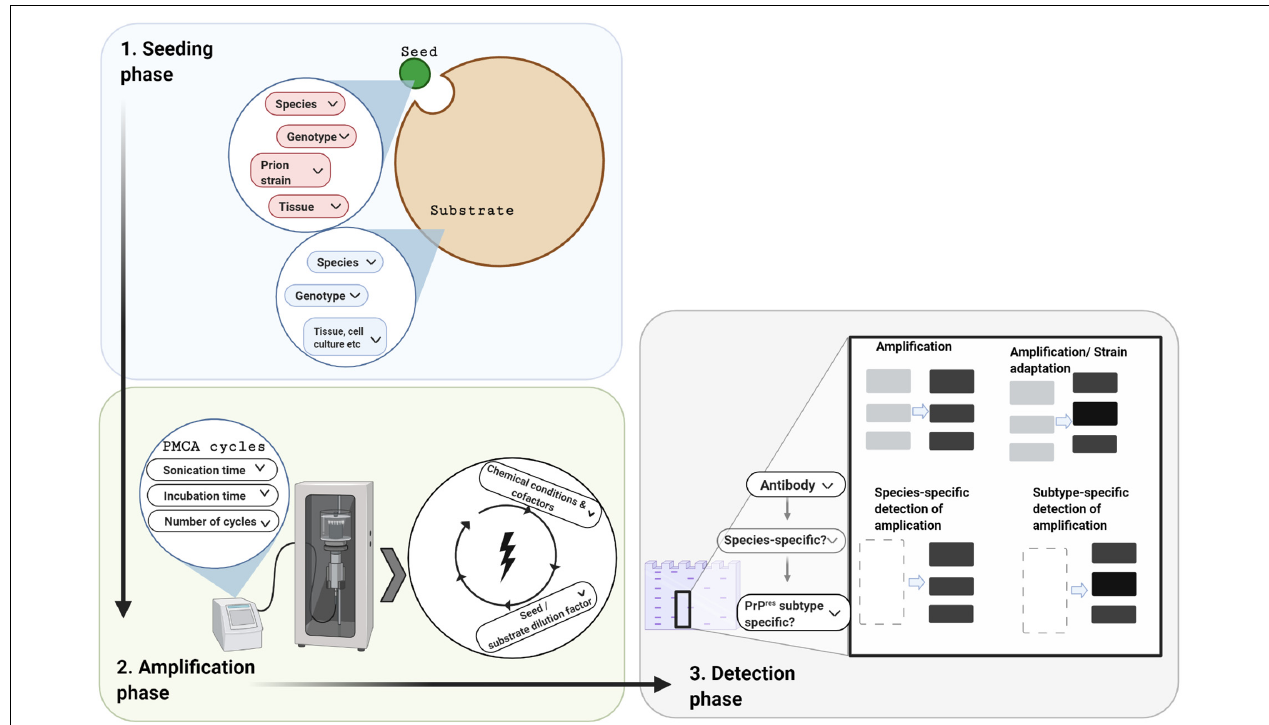
FIGURE 2 | Protein misfolding cyclic amplification and its three technical phases. In designing a PMCA experiment there are three phases to consider, which each involve decisions depending on the research question and resources available. In the seeding phase, a minute amount of PrP Sc seed (small green circle) is mixed with an excess of PrP C substrate (large brown circle). For both these components, the species, PRNP genotype, and tissue source need to be chosen. In addition, the prion strain of the seed needs to be selected. In the amplification phase, cofactors may be added to the above mixture which is then subjected to cycles of incubation and sonication. Choices are required for the physical parameters (e.g., cycle time, incubation versus sonication time per cycle, number of cycles, and amplitude of ultra-sonication). In the detection phase, the amplified product is quantified and/or characterized, usually by western blotting following limited protease digestion. Cross-species amplification can be confirmed with species-specific detection antibodies, whereas alterations in the PrP res molecular profile can be confirmed with subtype-specific